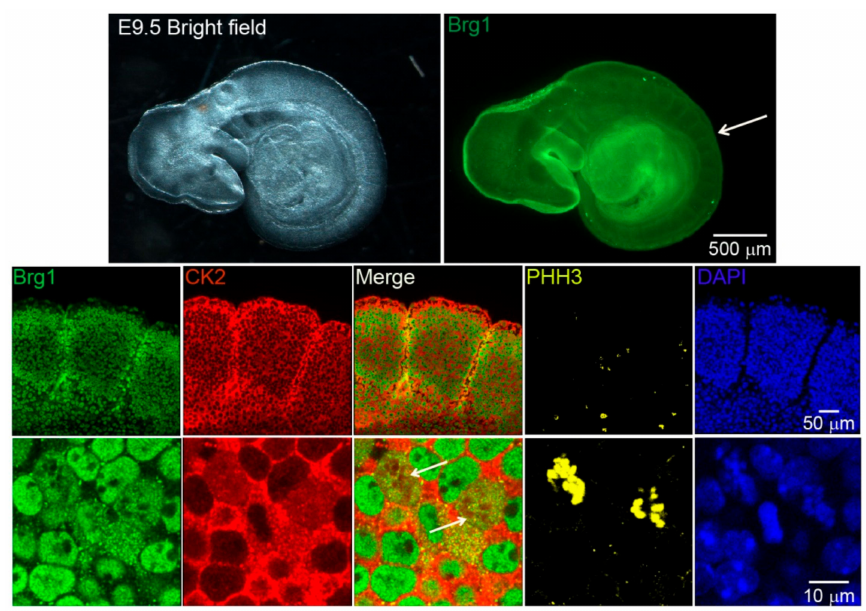
Figure 1. Casein kinase 2 (CK2) and Brahma-related gene 1 (Brg1) co-localize in mitotic cells of developing somites in mouse embryos. Representative confocal microscopy images from mice embryos showing the expression of Brg1 (green), CK2 (red), and phosphorylated histone H3 (PHH3, yellow) in somites of embryonic day 9.5 (E9.5) mice. The nuclei were stained with DAPI (blue). The white arrow in the upper panel points to the area of enlargement in the lower panels. The white arrows in the lower panel point to mitotic cells. Three di ff erent embryos were